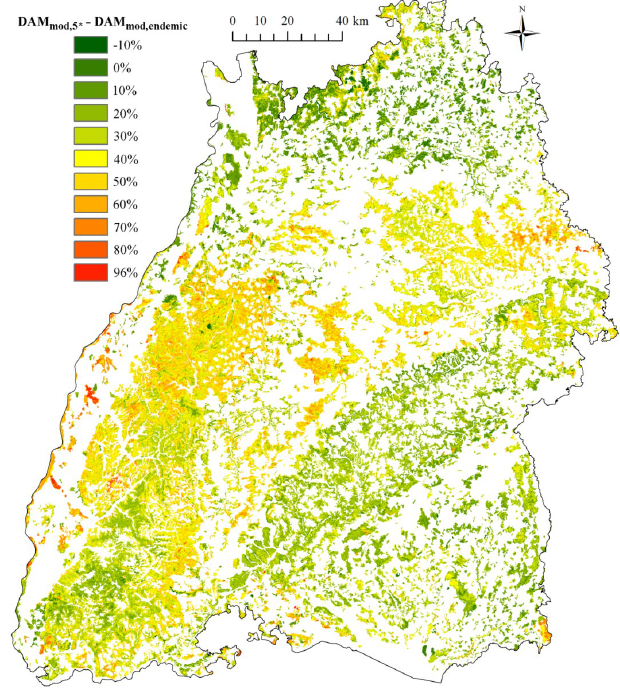
Figure 16. Difference map of modeled proportions of storm-damaged timber in the period 1999–2003 with Lothar gust speed field being included in model building ( DAM mod ,5 ˚ ) and modeled proportions of endemically storm-damaged timber DAM mod , endemic . The legend values indicate highest class